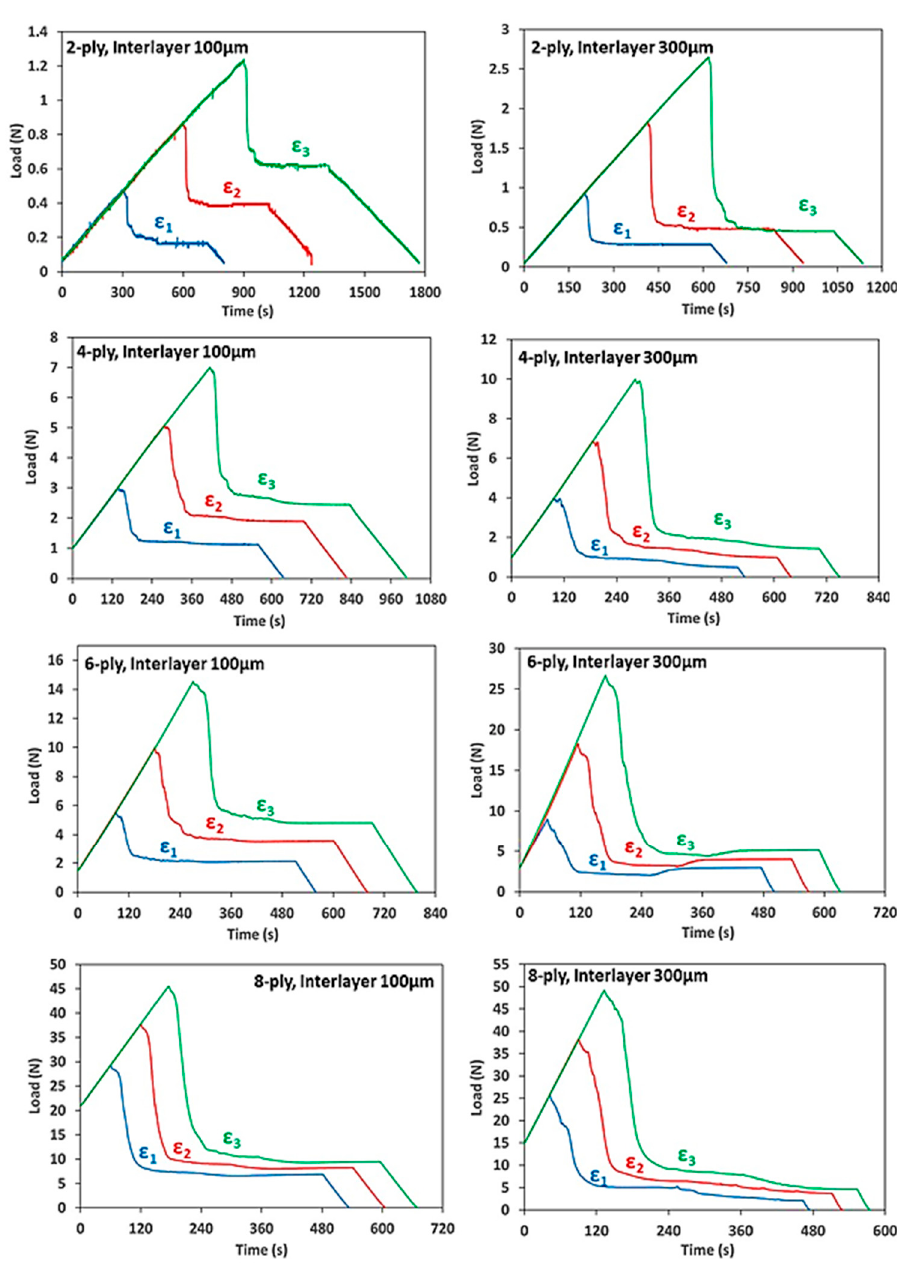
Figure 6. Instrumented thermo-mechanical cycle for SMP testing ( ε 1 = 0.06%, ε 2 = 0.12%, ε 3 =